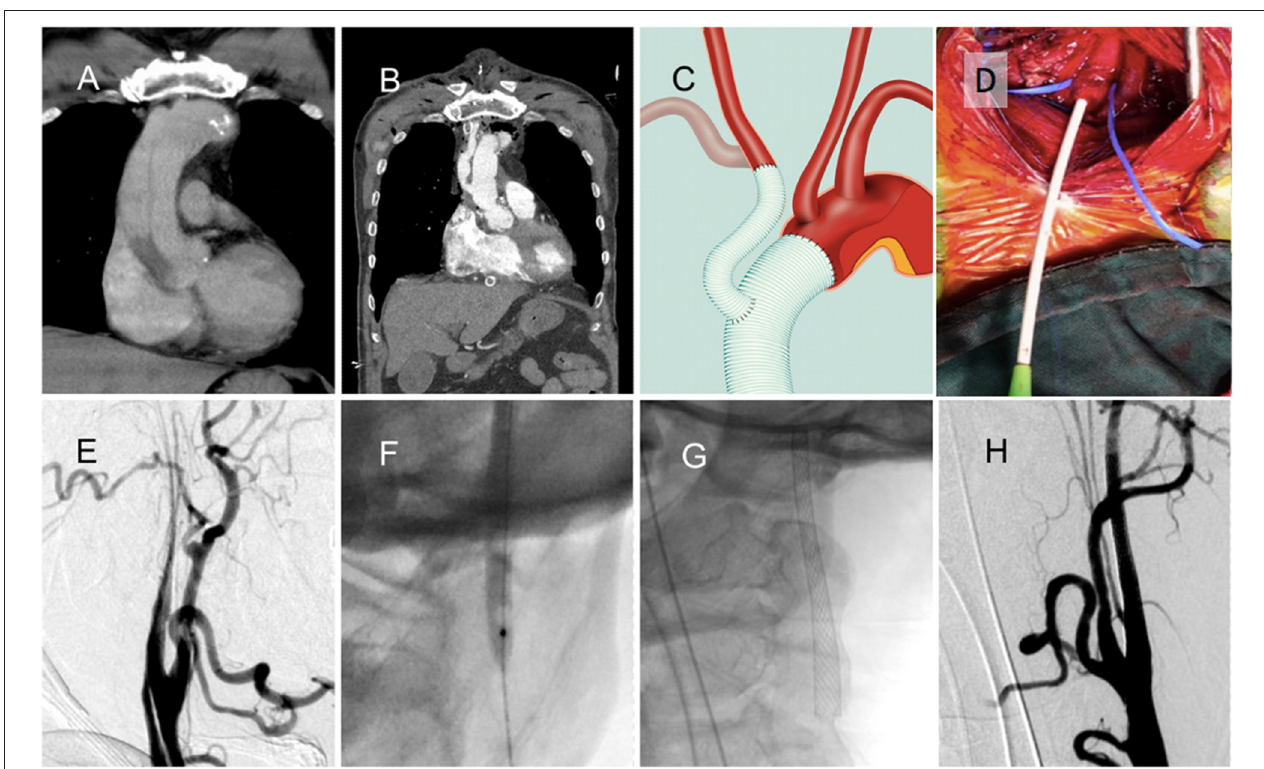
FIGURE 2 | A patient with acute ischemic stroke after type A aortic dissection surgery. (A) Initial type A dissection before operation. (B) Ascending aortic arch replacement with graft placement, innominate artery debranching, and graft reimplantation. (C) Schematic of heart surgery. (D) Carotid exposure and puncture from the right neck. (E) Internal carotid artery (ICA) dissection and near-complete occlusion with string sign. (F) Balloon angioplasty of the occlusion site. (G) Carotid stent deployment. (H) Complete recanalization of the